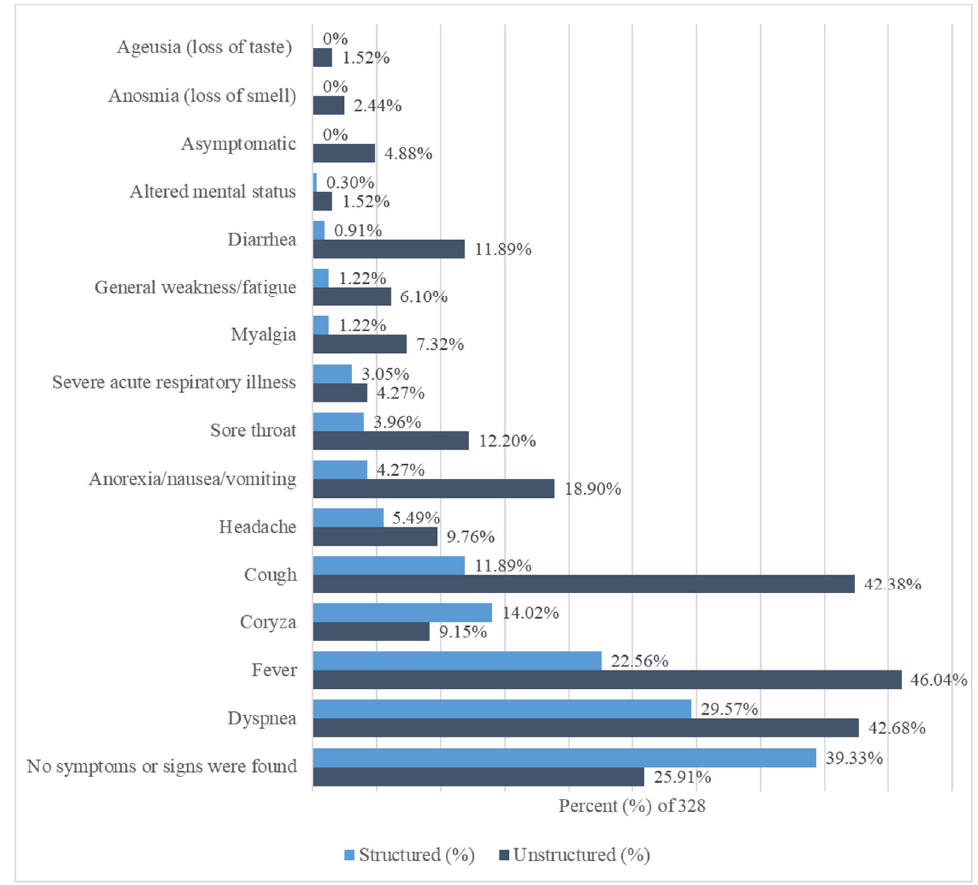
Figure 2. COVID-19 signs and symptoms in structured and unstructured clinical data. The signs and symptoms are sorted by structured data’s percentages from highest (down) to lowest (up).